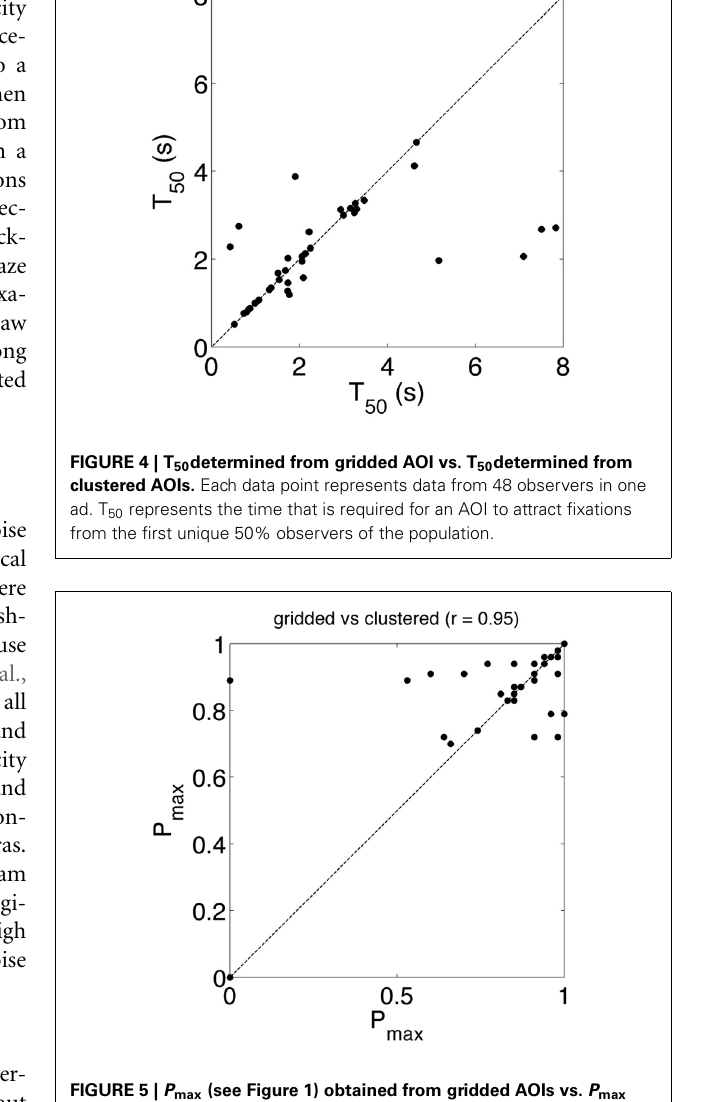
FIGURE 5 | P max (see Figure 1) obtained from gridded AOIs vs. P max obtained from clustered AOIs. P max refers to the proportion observers that fixated a target AOI (in this study the AOI with the brand logo) at least one time. In most ads the P max is high ( > 0.8) and the correlation between the P max from gridded vs. clustered is